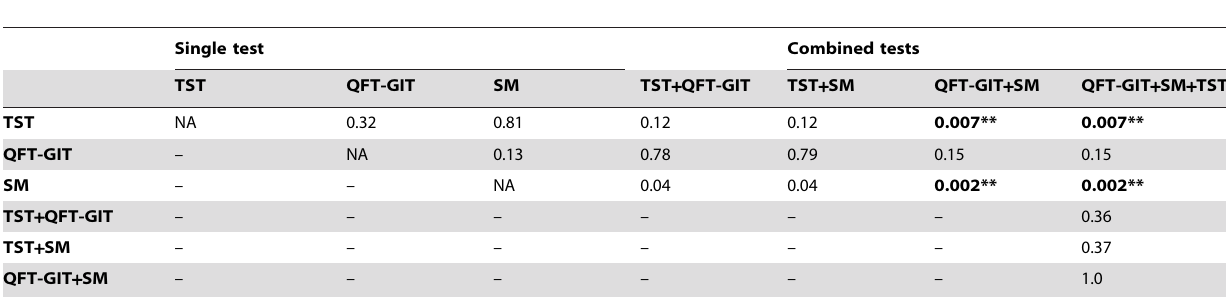
Table 10. p values of multiple comparisons among tests evaluating sensitivity for active TB in active pulmonary TB patients (as reported in Table 9) with